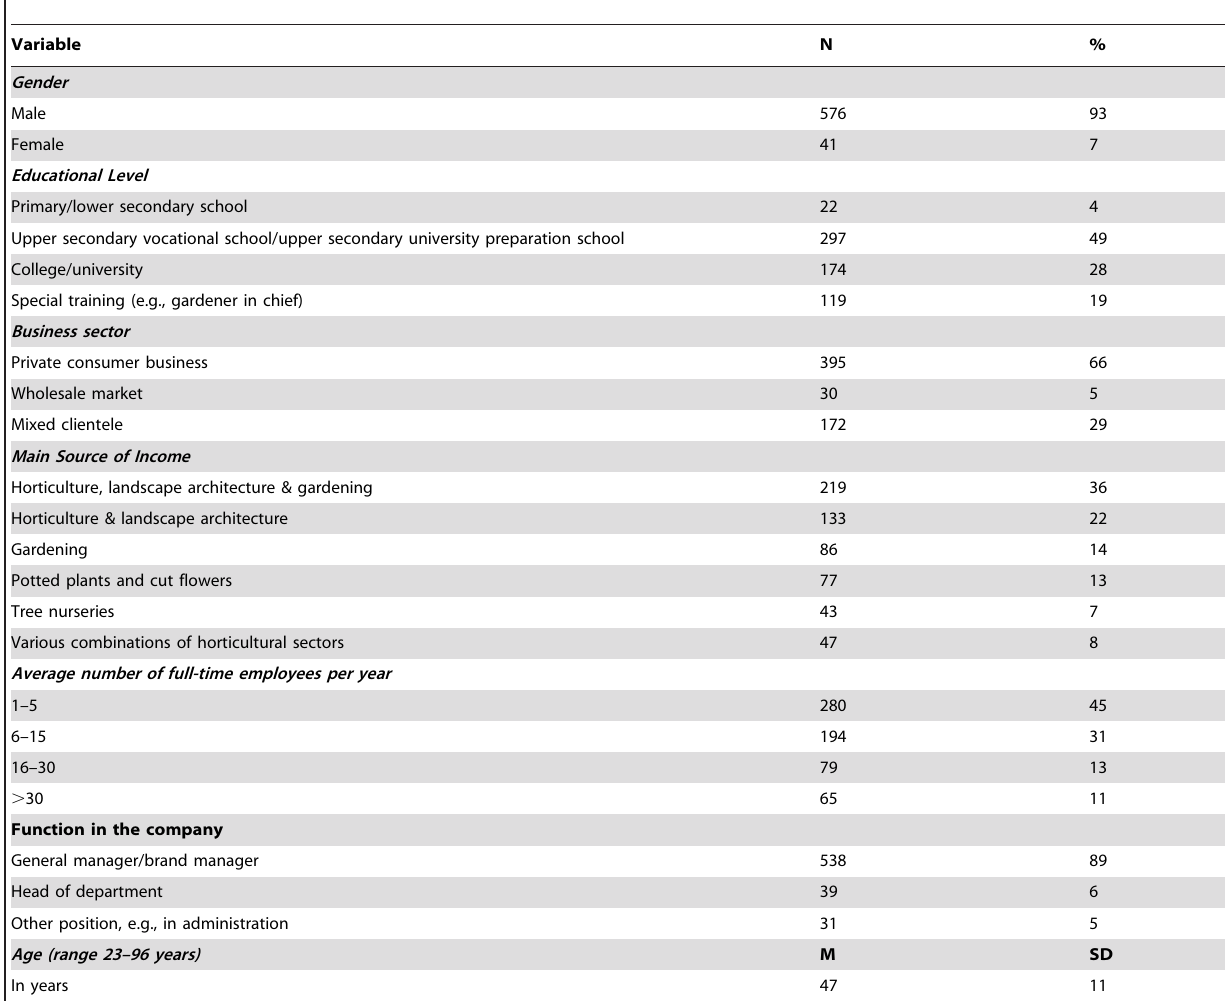
Table 3. Socio-demographic characteristics of the analysis sample ( N =